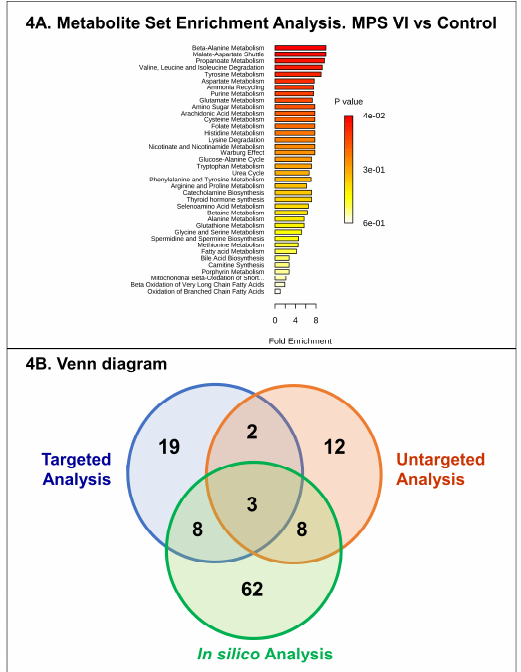
Figure 2. Bar plot showing of dermatan sulfate, total carnitine, free carnitine, and the 13 amino acids and their related −log ( p ) values between MPS VI and controls. Cut-off is set to FDR = 0.05. Corresponding p -values are presented in Table 3. Int. J. Mol. Sci. 2019 , 20, x; doi: FOR PEER Table 2. Significantly dysregulated pathways.